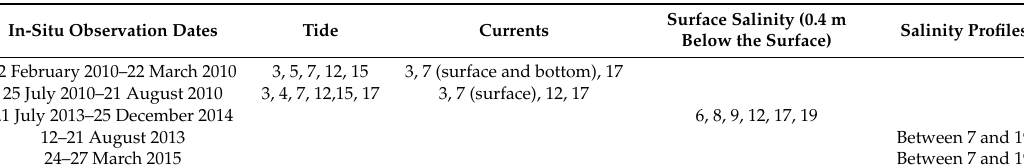
Table 1. Seasonal hydrographic data collected at di ff erent stations of CE during the period of 2010 to 2015.